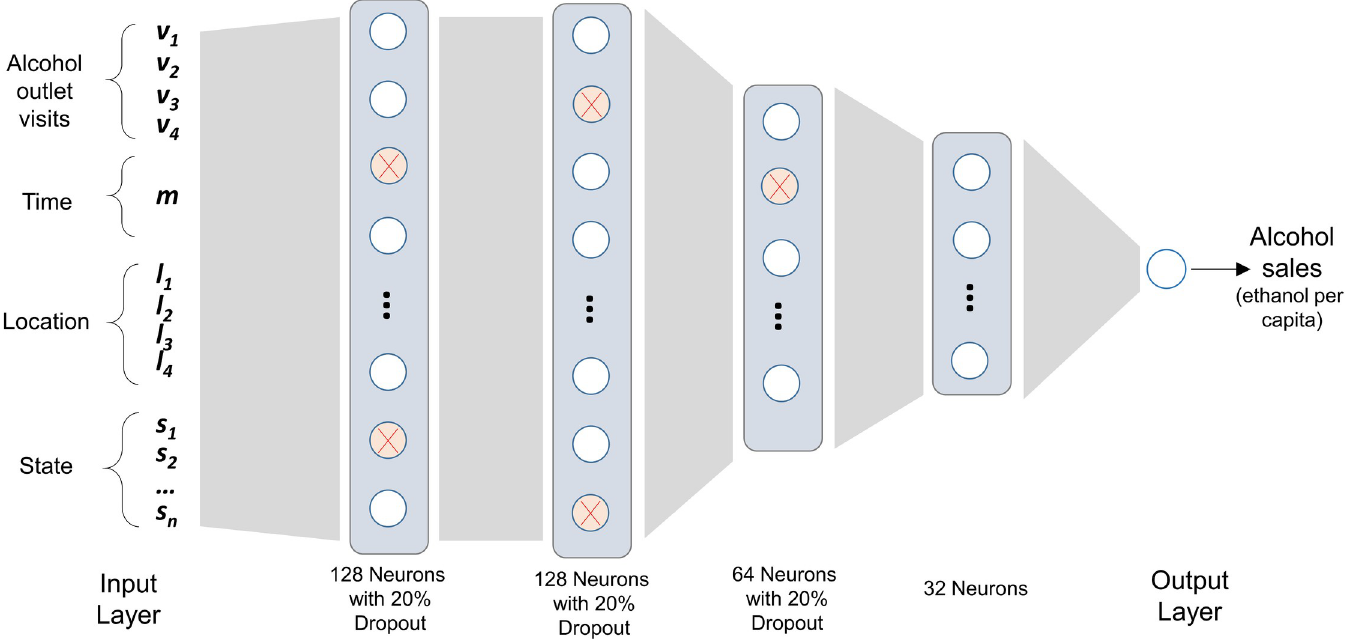
Fig 1. The architecture of the DNN model for estimating alcohol